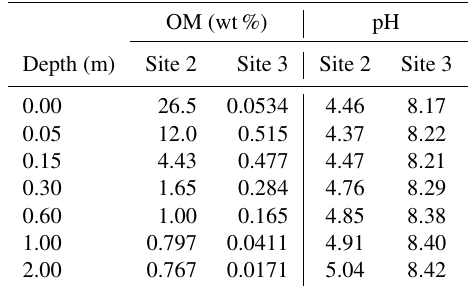
Table 9. Observed soil depth profiles of OM and pH ∗